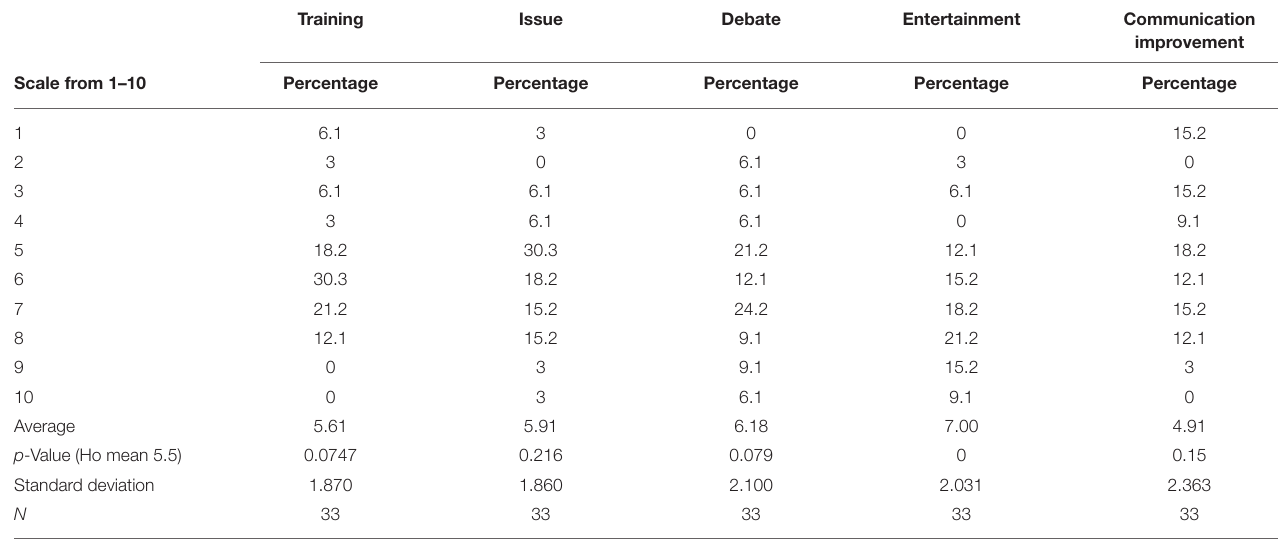
TABLE 2 | Interest in training, their training solution, and debate/communication. Training Issue Debate Entertainment Communication